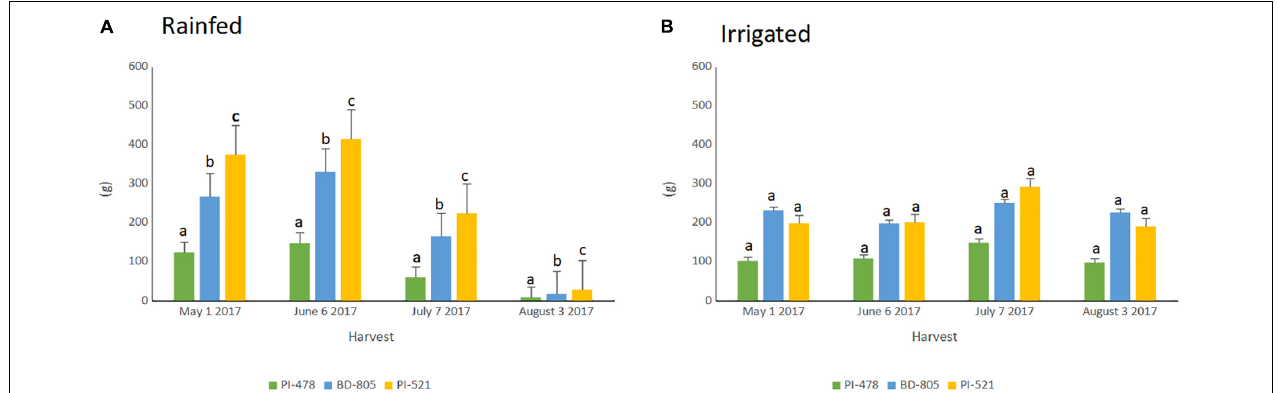
FIGURE 6 | Fresh biomass weight (g) recorded over four harvests within growing season of 2017 among three alfalfas spanning from May to August in irrigated (A) and rainfed (B) treatments. PI-478; PI478573; BD-805; Bulldog-805 and PI-521;PI502521. Means with different letter indicates biomass yield difference between alfalfa evaluated based on LSD (Alpha-0.05 value). TABLE 5 | Variability in root architectural traits of alfalfa studied in rainfed (with only rainfall as irrigation source) and irrigated conditions. Trait